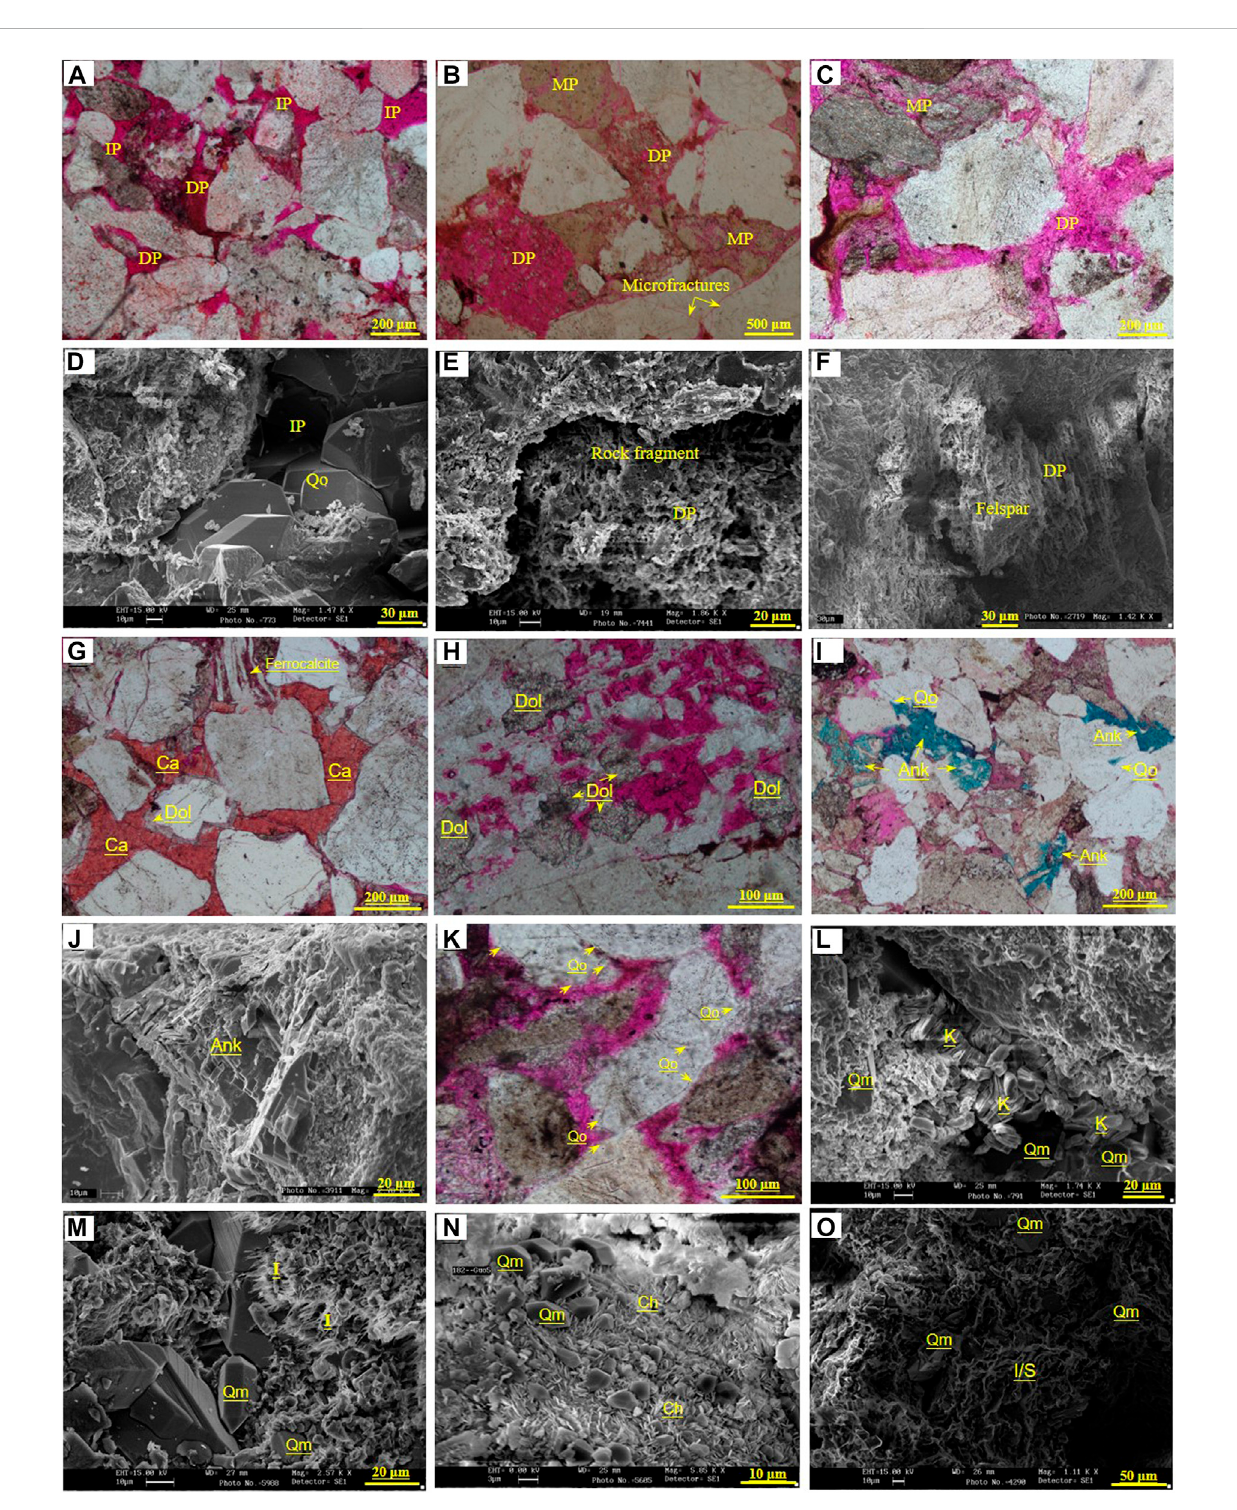
FIGURE 4 Photomicrographs showing typical pore types and diagenetic minerals of the J 2 x 1+2 sandstone reservoirs in the Taibei sag. (A) PPL view showing mixed pores of primary intergranular pores and dissolution pores (Well H803, 3998.59 m). (B) PPL showing intragranular dissolution pores and a small number of micropores (Well K23, 3991.77 m). (C) PPL showing micropores formed by interstitial materials dissolution (Well K23, 3992.69 m). (D) SEM image showing the remaining intergranular pore after quartz overgrowths fi llings (Well H803, 3998.63 m). (E) SEM image showing the dissolution pores of rock fragment (Well H801, 3865.65 m). (F) SEM image showing the feldspar dissolution pores (Well YB3, 3836.39 m). (G) PPL view showing the early poikilitic calcites (Well H801,3868.25 m). (H) PPLimageviewingtheintragranulardissolutionporeswerereplacedbythedolomites(WellK33,3801.94 m). (I) PPLimageshowingthe dissolved frameworks replaced by ankerites partly or entirely (Well L2, 3473.01 m). (J) SEM image showing the ankerite cement with rhombohedral crystals (Well G12, 4009.36 m). (K) PPL image showing the quartz overgrowths (Well K31, 4012.55 m). (L) SEM image showing the intergranular pores fi lled by the kaolinite aggregates (Well H803, 4041.04 m). (M) SEM image showing pore- fi lling euhedral quartz crystals and illites (Well J3, 4125.75 m). (N) SEM image showing the euhedral quartz crystals and chlorites (Well G5, 3650.02 m). (O) SEM image showing the I/S mixed layers (Well K23, 3991.14 m). IP- intergranular pores; DP- dissolution pore; MP- micropore; Qo-quartz overgrowths; PPL-plane-polarized light; SEM-scanning electron microscope; Ca-calcite; Dol- dolomite; Ank- Ankerite; K- kaolinite; I- illite; I/S- illite/smectite mixed layer; Ch-